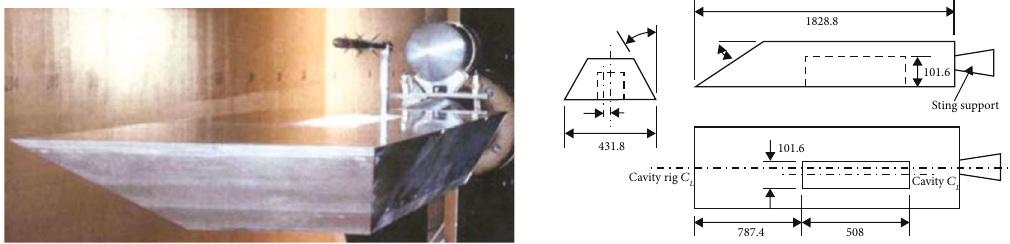
Figure 1: Noise test of M219 cavity in wind